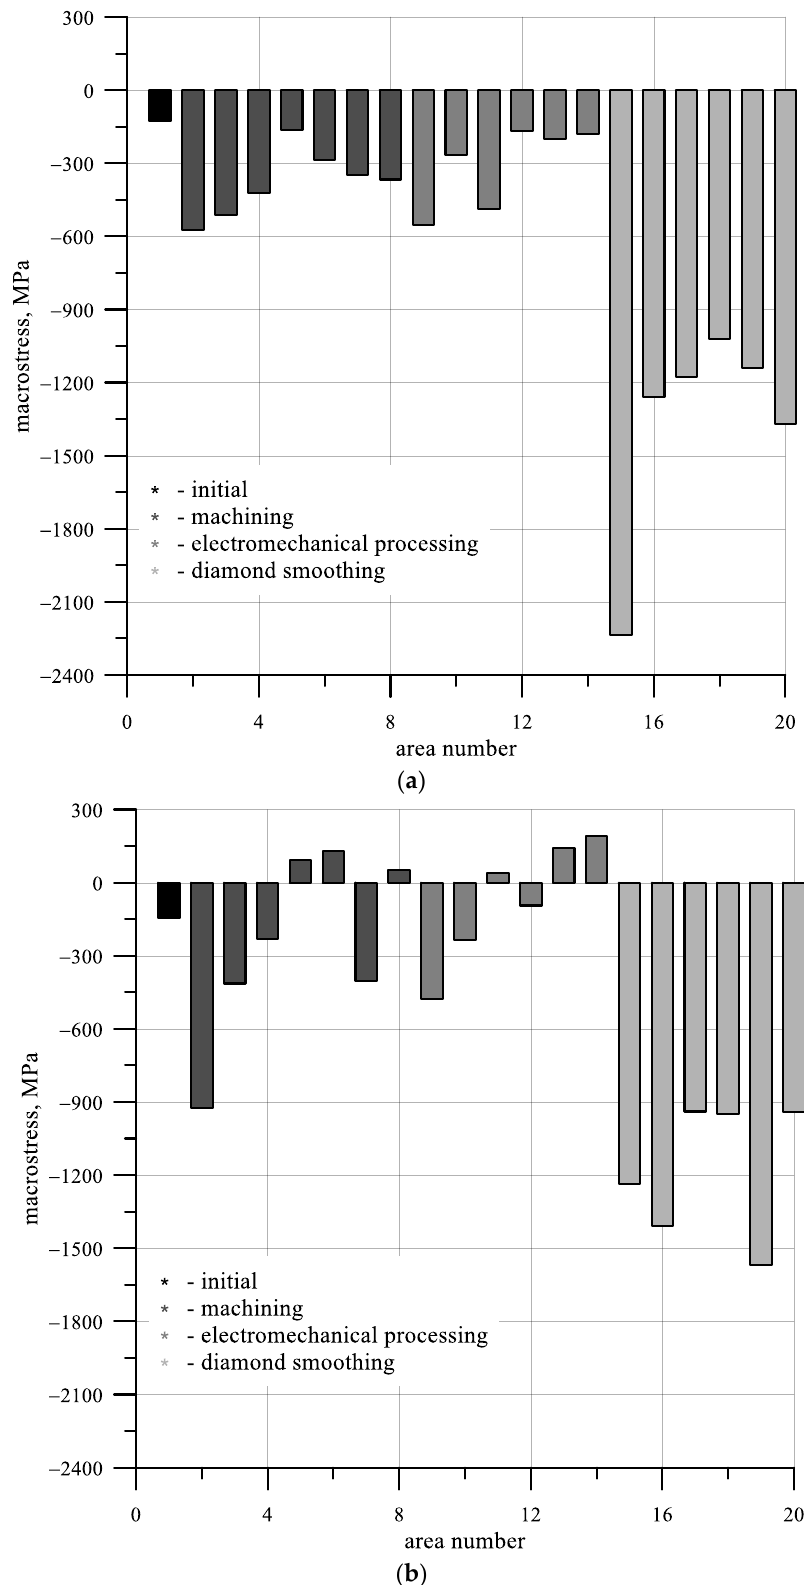
Figure 5. A graph of the dependence of axial ( a ) and circumferential ( b ) macrostresses value.